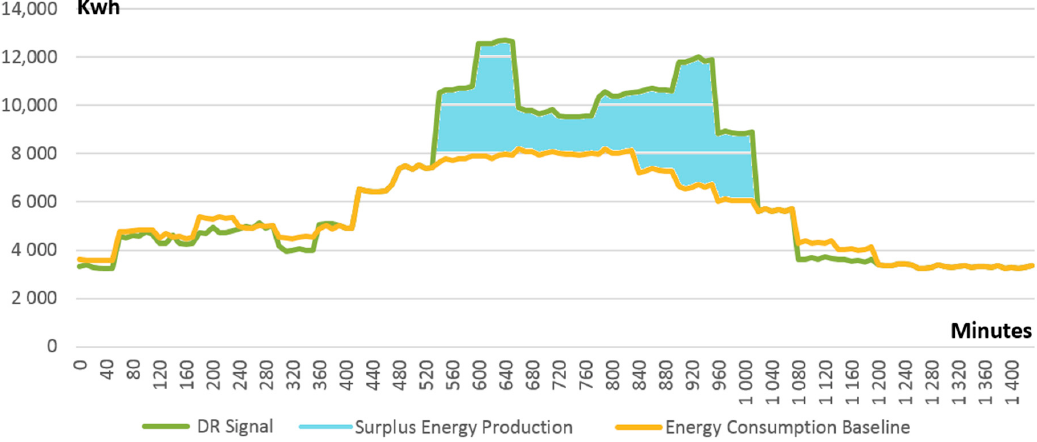
Figure 8. Smart grid energy unbalanced state before blockchain based optimization and planned DR signal.